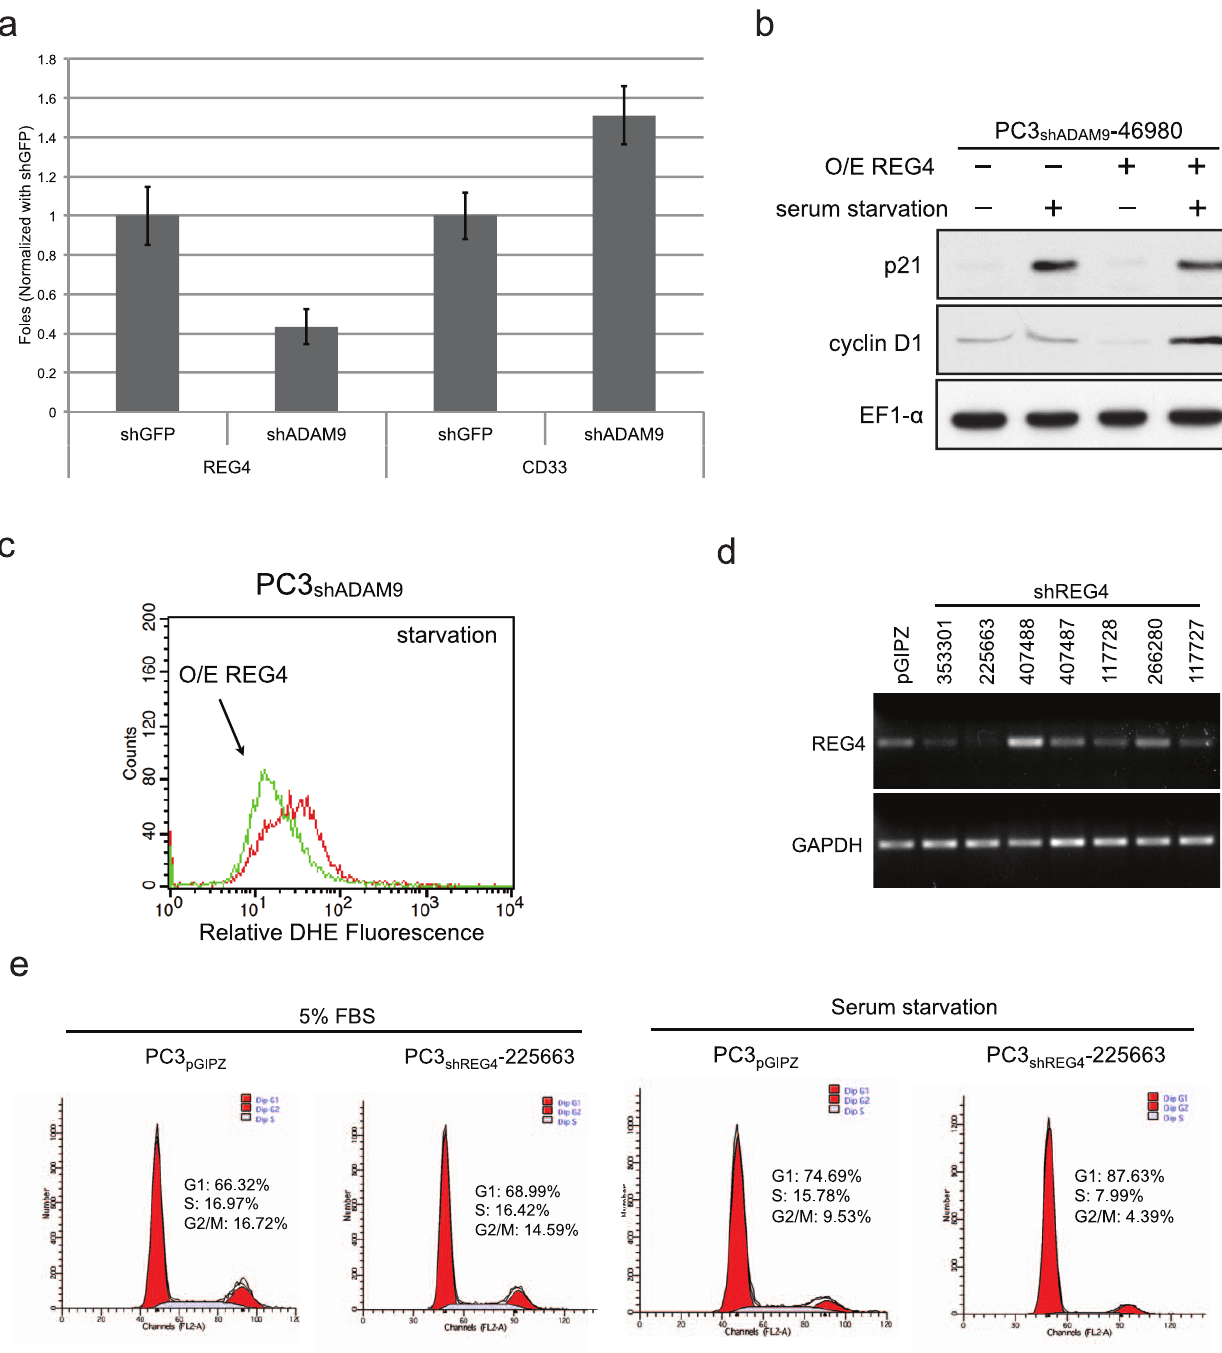
Figure 6. Decreased REG4 and increased p21 Cip1/WAF1 , p27 Kip1 , and cyclin D1 expression in ADAM9 knockdown prostate cancer cells. (a) Quantitative PCR confirmed the decrease of REG4 mRNA and increase of CD33 mRNA. (b) Overexpression of REG4 decreased p21 Cip1/WAF1 expression under FBS starvation conditions in PC3 shADAM9 . (c) The starvation-induced increase in superoxide levels was reversed by overexpression of REG4 in PC3 shADAM9 . (d) The strongest inhibition of REG4 expression by shREG4 lentiviral vectorwas observed in PC3 shREG4 -225663 by RT-PCR. (e) PC3 shREG4 -225663 reduced the S-phase and increased the G1-phase populations under starvation conditions. connection between ADAM9 and REG4 signlaing in cell proliferation and cell survival will improve the understanding of the underlying mechanisms in CRPC progression and therapy resistance.